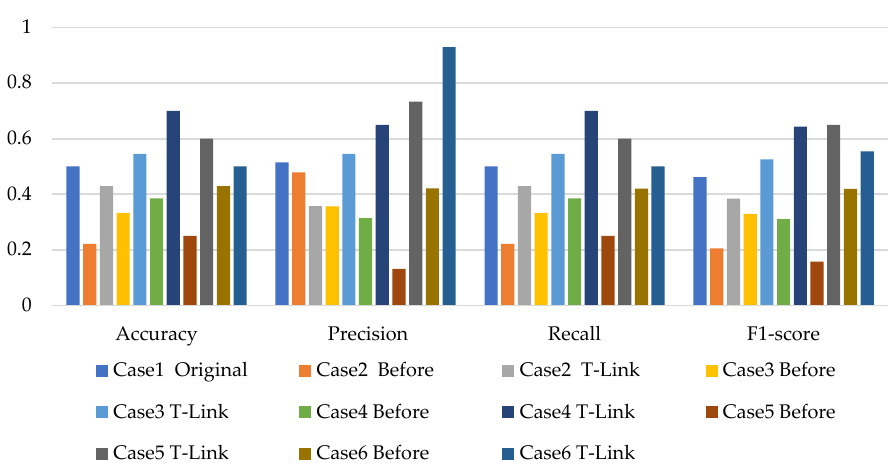
Figure 6. Simulation performance of NBC classification with T-link.